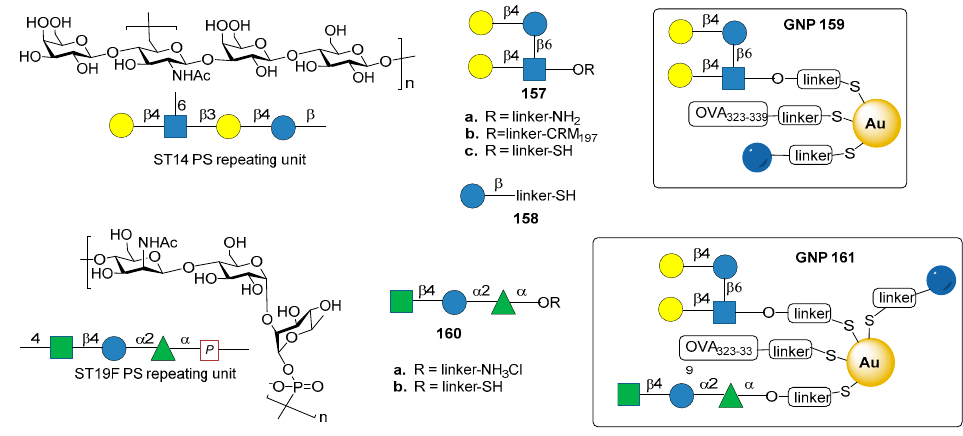
Figure 17. Repeating unit of S. pneumoniae type 14 (ST14) and S. pneumoniae type 19F (ST19F),